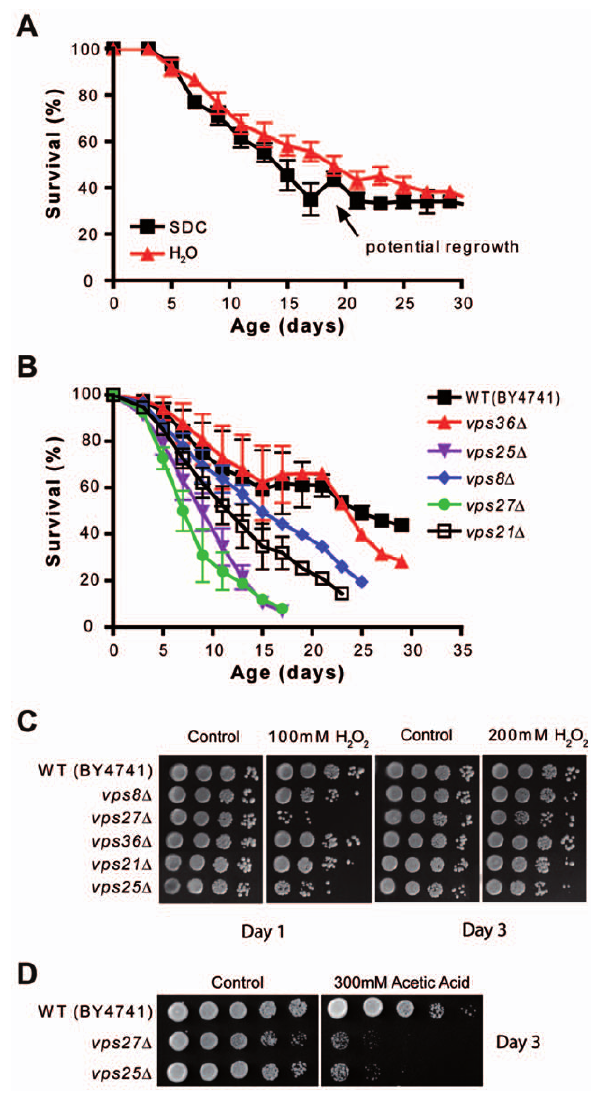
Figure 2. VPS genes are required for starvation/extreme CR– dependent life span extension and resistance to oxidative stress and acetic acid. (A) CLS of wild type (BY4741) in SDC medium and under starvation/extreme CR. Starvation/extreme CR was obtained by transferring the yeast culture to water at day 3 (see Materials and Methods). The arrow indicates the time at which adaptive regrowth might be occurring. (B) CLS of wild type (BY4741) and of the vps36 D , vps25 D , vps8 D , vps27 D , and vps21 D deletion mutants. Yeast cultures were transferred from medium to water at day 3. Data show mean 6 SEM of three experiments. (C) Resistance to H 2 O 2 of the same mutants. After a 30 minute-exposure to 100–200 mM H 2 O 2 in K-buffer, day 1–3 cells from SDC cultures were serially diluted and plated on YPD plates. D) Resistance to acetic acid of wild type cells, vps25 D and vps27 D mutants. Day 3 cultures were exposed to 300 mM of acetic acid